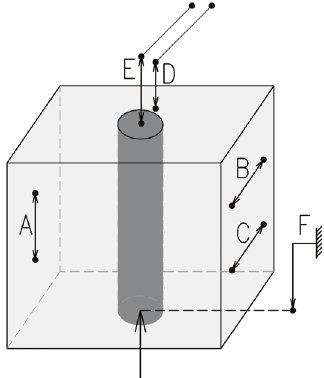
Fig. 5. Location of displacement